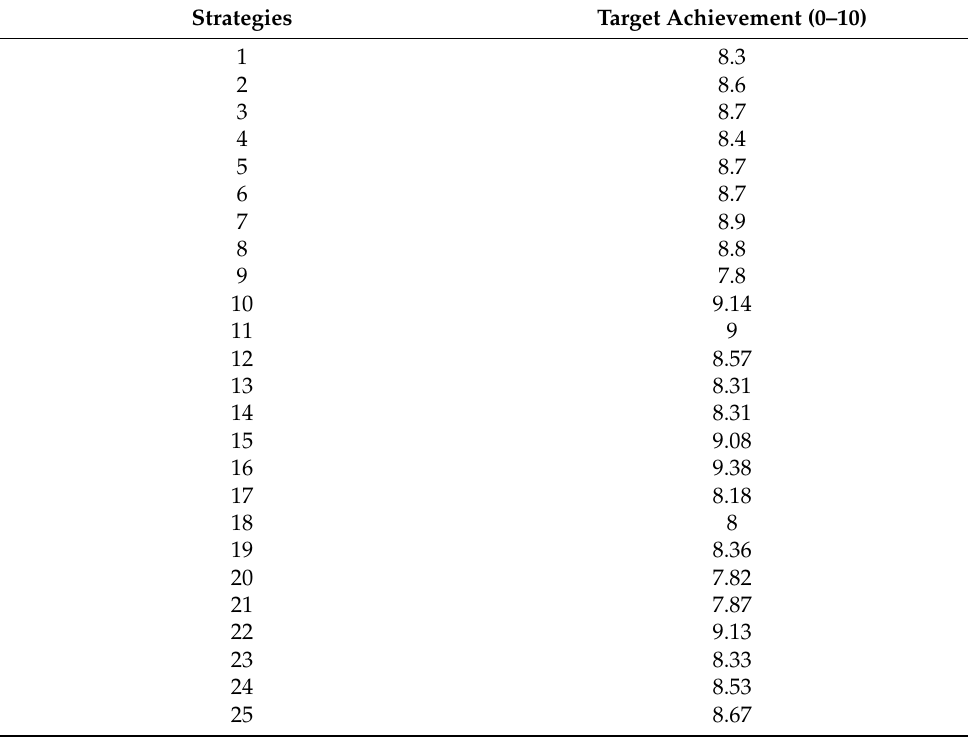
Table A4. Achievement of the objective after implementation of the strategies.